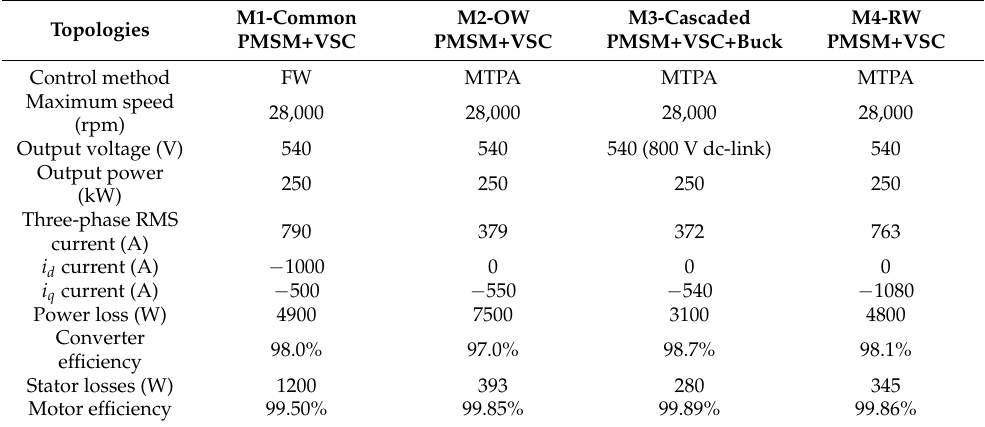
Table 2. Experimental results of four models.